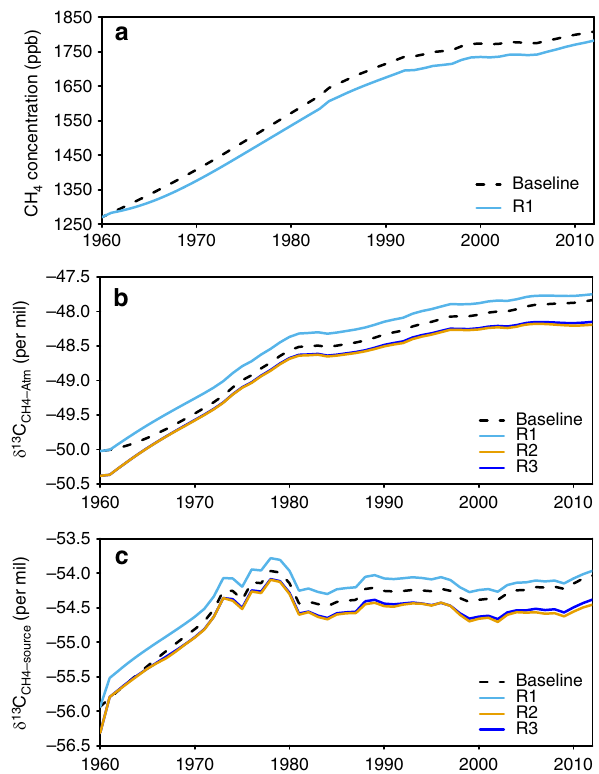
Fig. 6 Global box model simulations of atmospheric CH 4 concentration, the box model results on δ 13 C CH4-atm , and the isotopic source signature weighted by all sources ( δ 13 C CH4-source ). In the simulation of R1, only the revised F CH4-ruminant is used and δ 13 C CH4-ruminant set to default value of − 62 ‰ previously used by ref. 5, 43 ; In R2, the revised F δ 13 C CH4-ruminant are used (see Methods). R3 is the same as R2 but with constant δ 13 C CH4-ruminant at − 64.49 ‰ for the period of 1961 – 2012. The differences between R1 and baseline are the effects of the revised F CH4- ruminant ; the differences between R2 and R1 are the effects of the revised δ 13 C CH4-ruminant ; the differences between R3 and R2 are the effects of the δ 13 C CH4-ruminant variation (i.e., the slightly decrease from to − 64.93 ‰ in 2012). Source data are provided as a Source Data fi